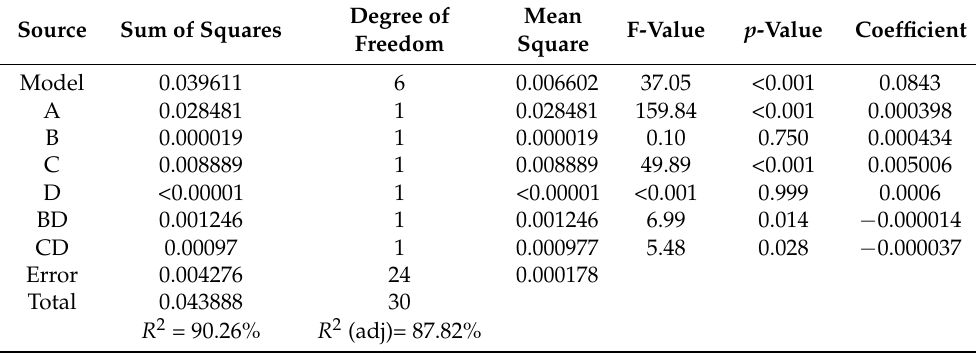
Table 7. The ANOVA of the reduced regression model for gap clearance (GC) of EDM with side flushing. Degree Source Sum of Squares of Freedom